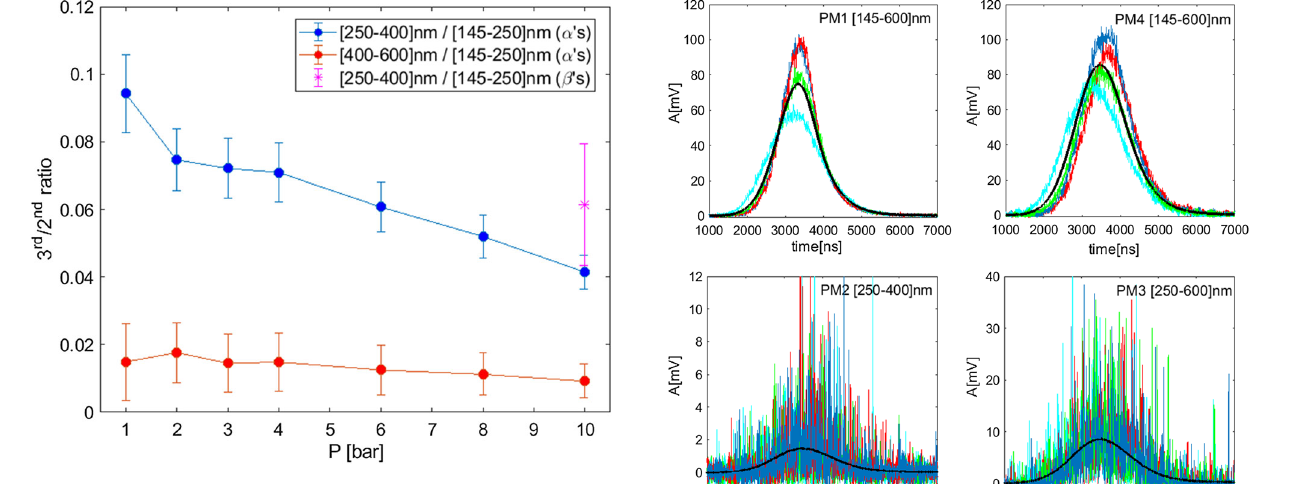
Fig. 15 Ratio of 3rd to 2nd continuum scintillation for α -excitation, considering the 250–400 nm and 400–600 nm bands (blue and red, respectively), obtained in recombination-free conditions (i.e., above 50 V/cm/bar). The pink point represents the ratio for β -electrons as obtained at 10 bar, where events are contained up to around 0.5 MeV